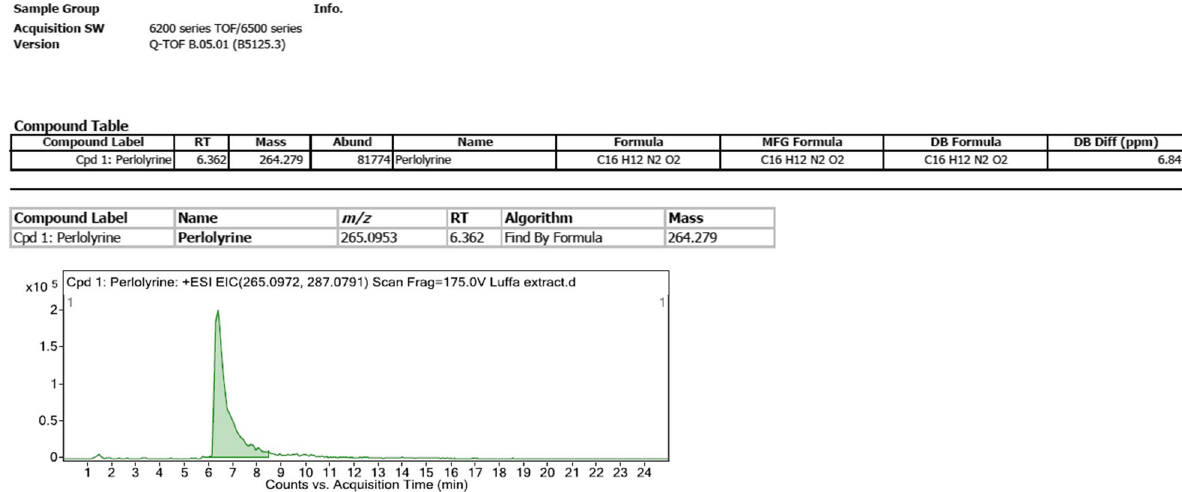
interactions with essential amino acids through hydrogen bonds and Vander Waal forces. Table 7 shows the identi- fied compound’s affinity for proteins associated with Alz- heimer’s disease.